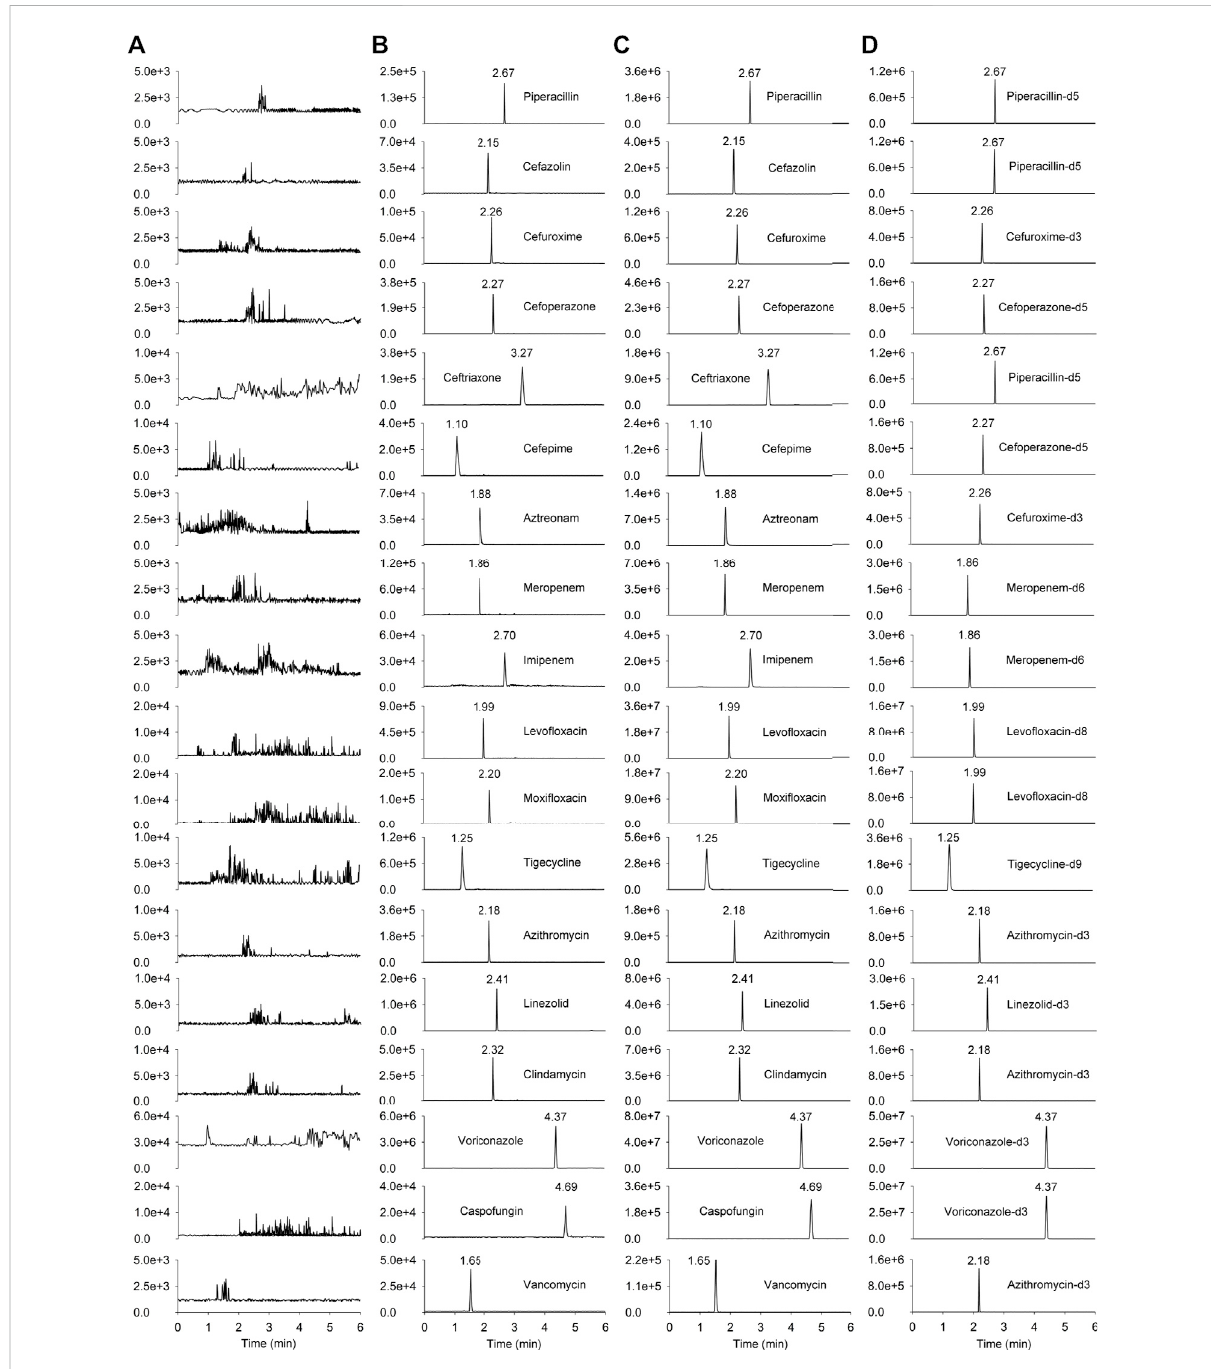
FIGURE 2 The chromatograms of the 18 antimicrobial agents and ISs. (A) blank human plasma sample; (B) blank plasma sample spiked with LLOQ; (C) patient ’ s plasma sample collected at 0.5 h after intravenous administration; (D) human plasma spiked internal standards (piperacillin-d5